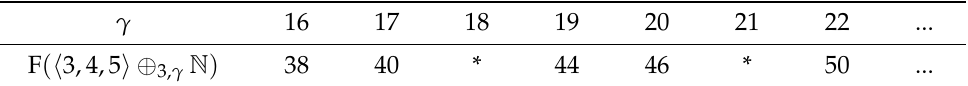
Table 2. Values of γ such that gcd ( 3, γ ) (cid:54) = 1 are marked with *. γ 16